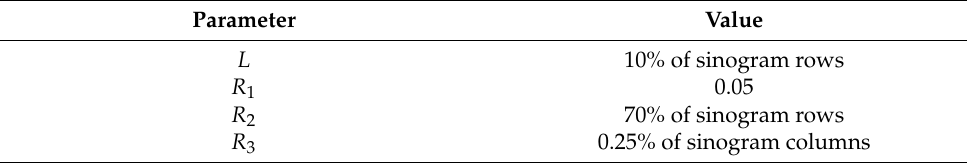
Table A3. HRA removal algorithm settings.